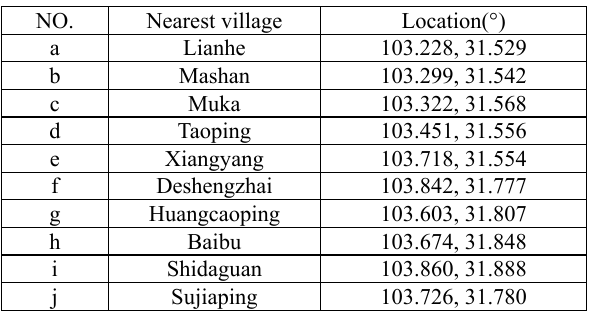
Table 1. The details of the 10 potential landslide